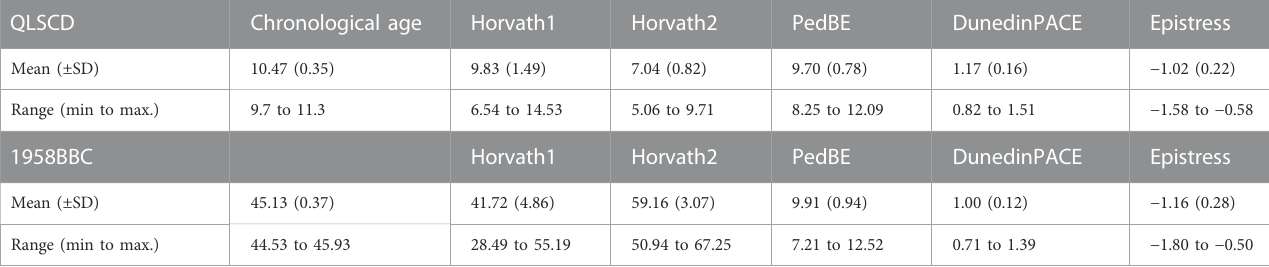
TABLE 1 Descriptive statistics of chronological and epigenetic age estimates, DunedinPACE, and Epistress in both cohorts a